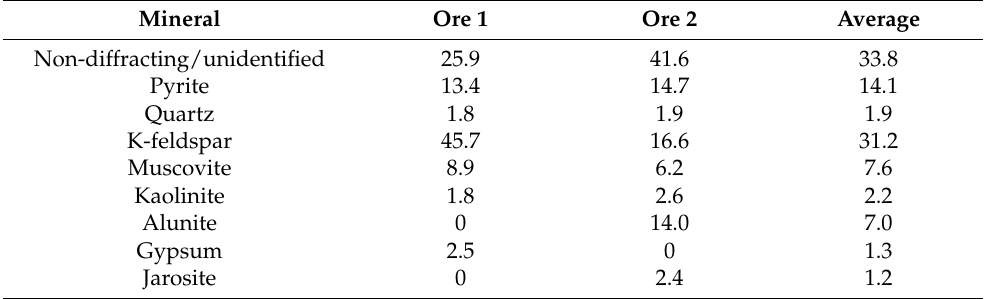
Table 1. Mineralogical composition (%) of the pyrite ores based on QXRD analysis.